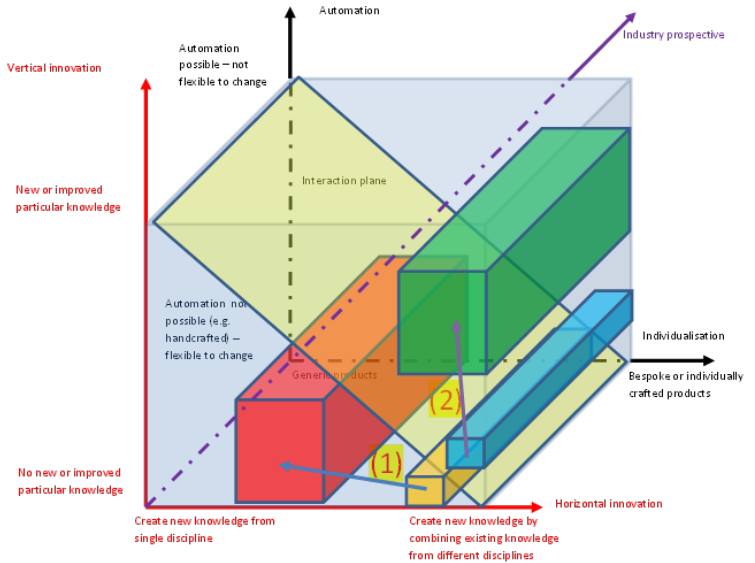
Figure 9. Magic Cube for Composite Manufacturing.